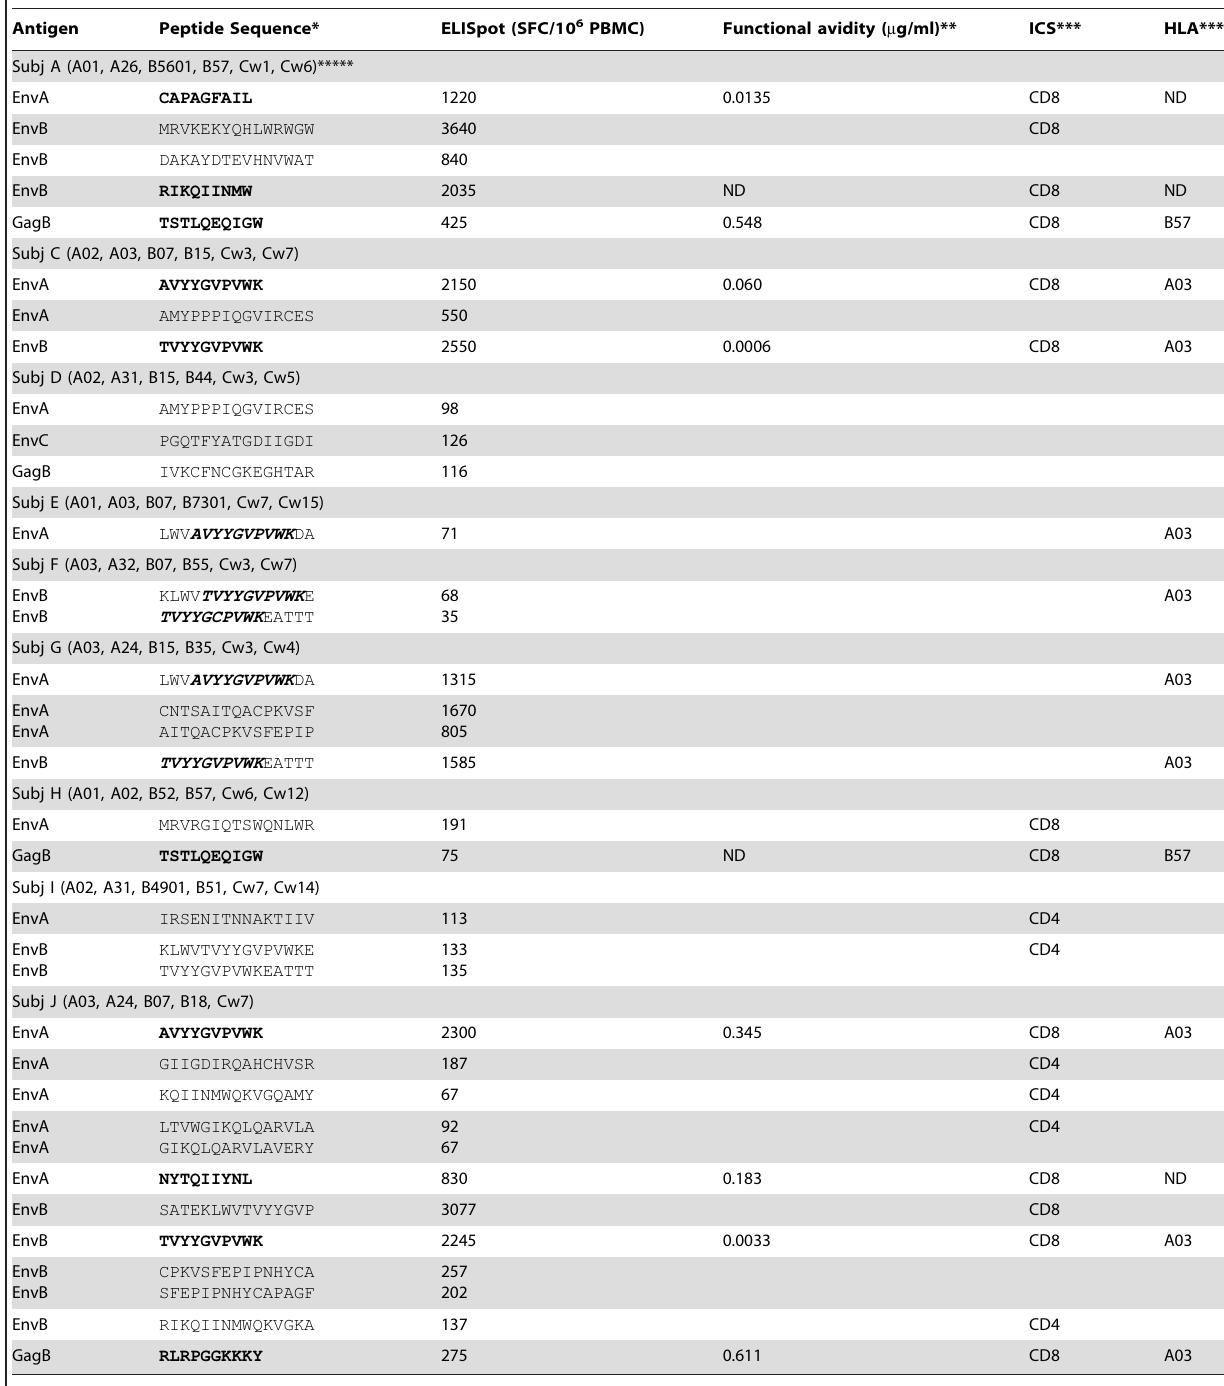
Table 2. Epitope mapping.